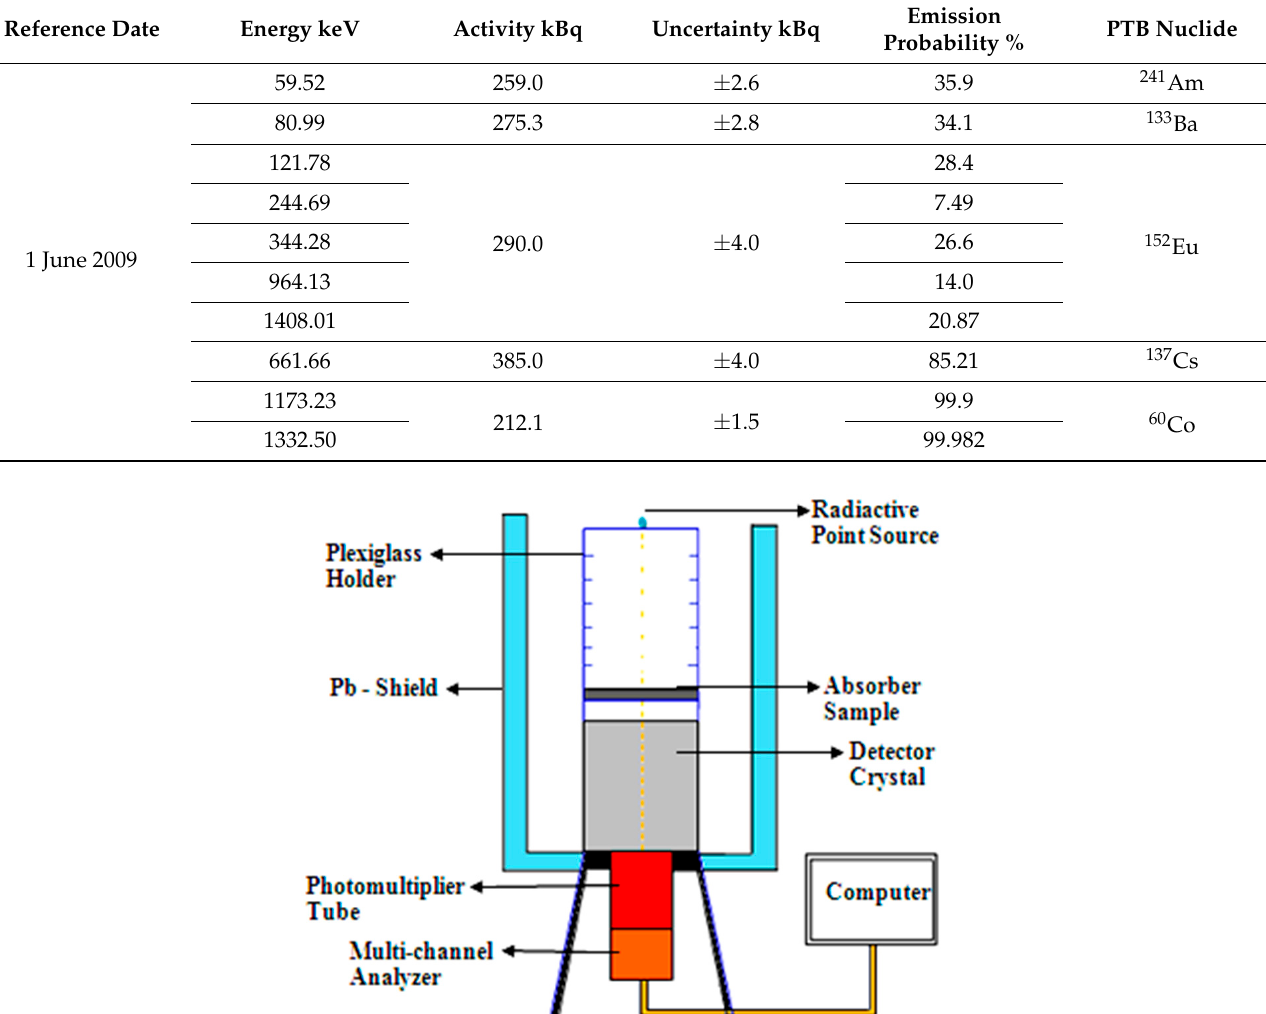
Table 2. The radioactive point sources and their characteristics which are used in the present work.